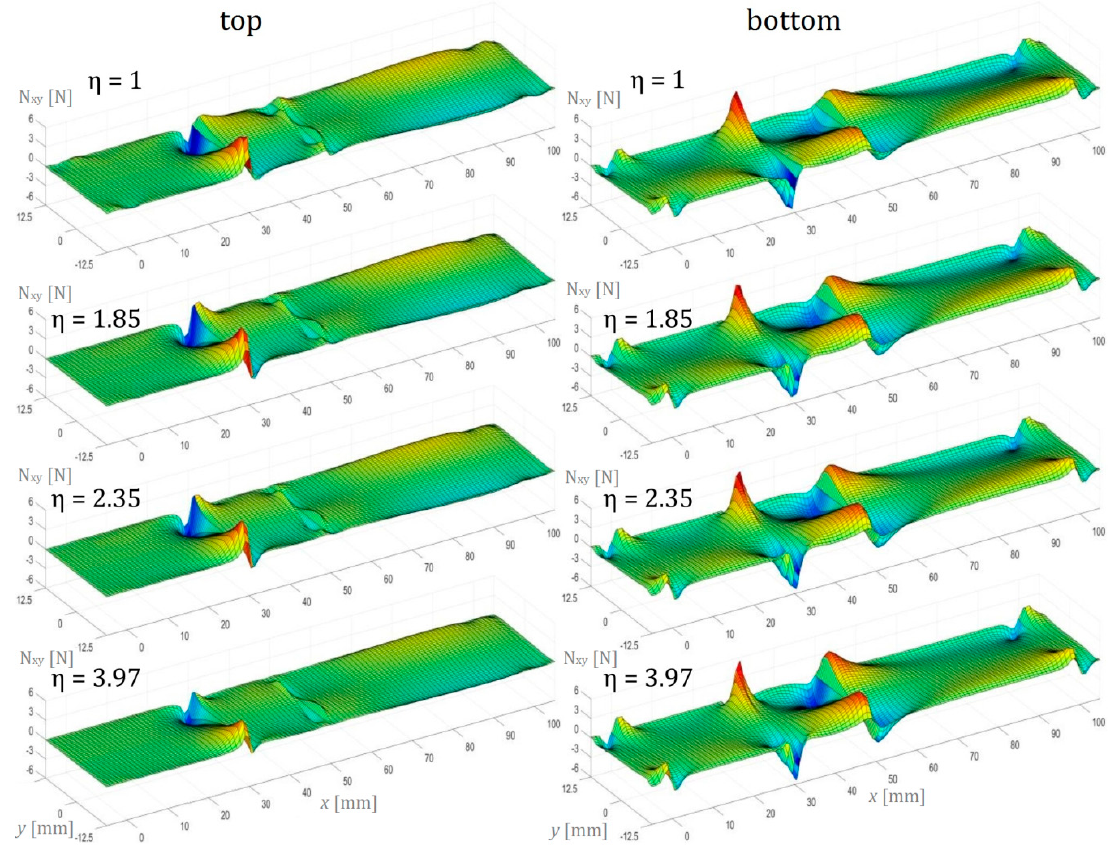
Figure 15. In-plane shear forces N xy per unit width in the AENF.